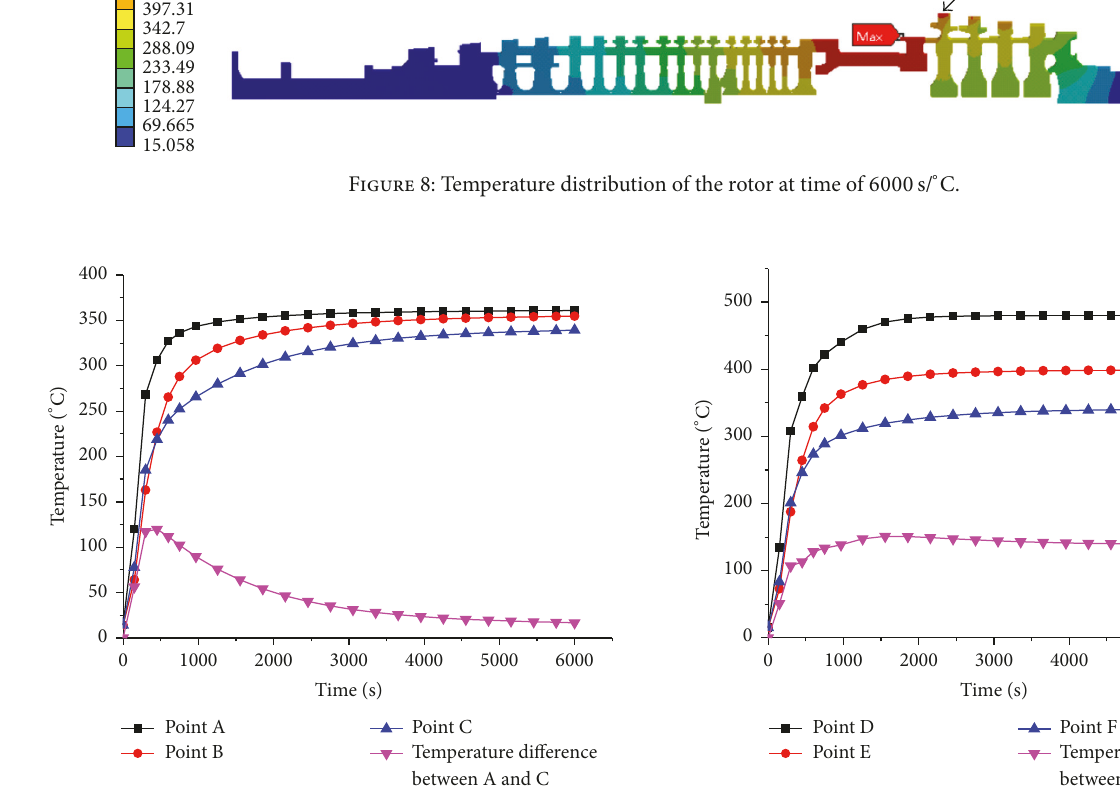
Figure 7: Temperature distribution of the rotor at time of 600s/ ∘ C. 451.91